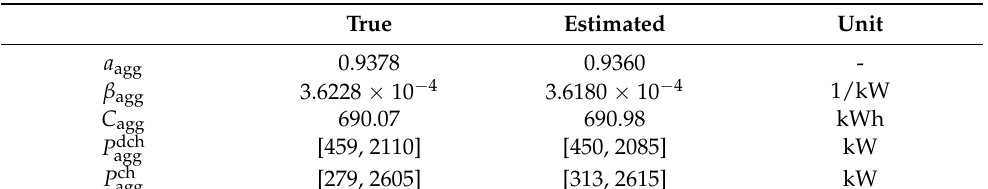
Table 4. Aggregate virtual battery model parameters.